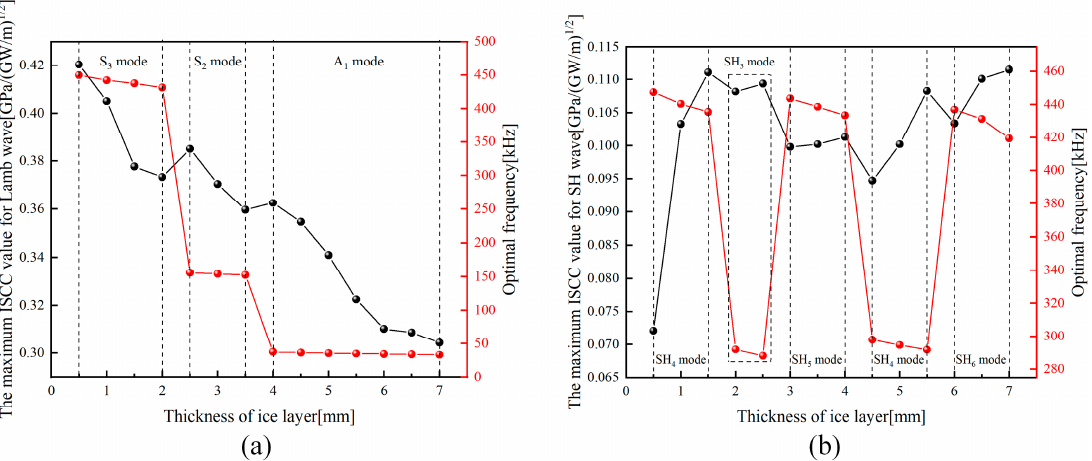
Figure 10. The e ff ects of ice thickness on maximum ISCC and optimal frequency: ( a ) Lamb wave; Figure 10. The effects of ice thickness on maximum ISCC and optimal frequency: ( a ) Lamb wave; ( b ) ( b ) SH SH wave.